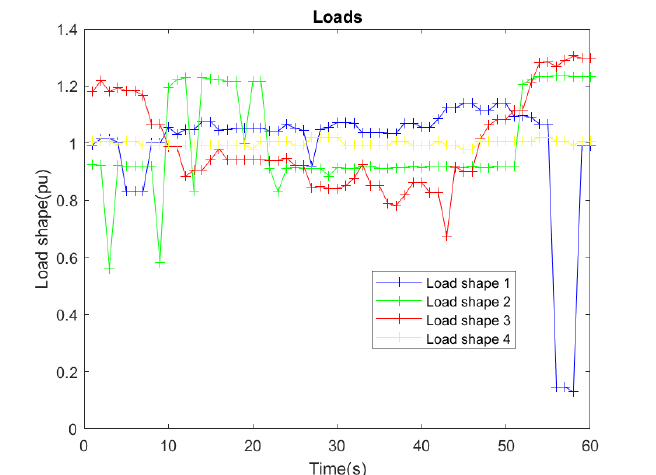
Figure 8. Solar irradiation variation across the one minute time frame of interest.